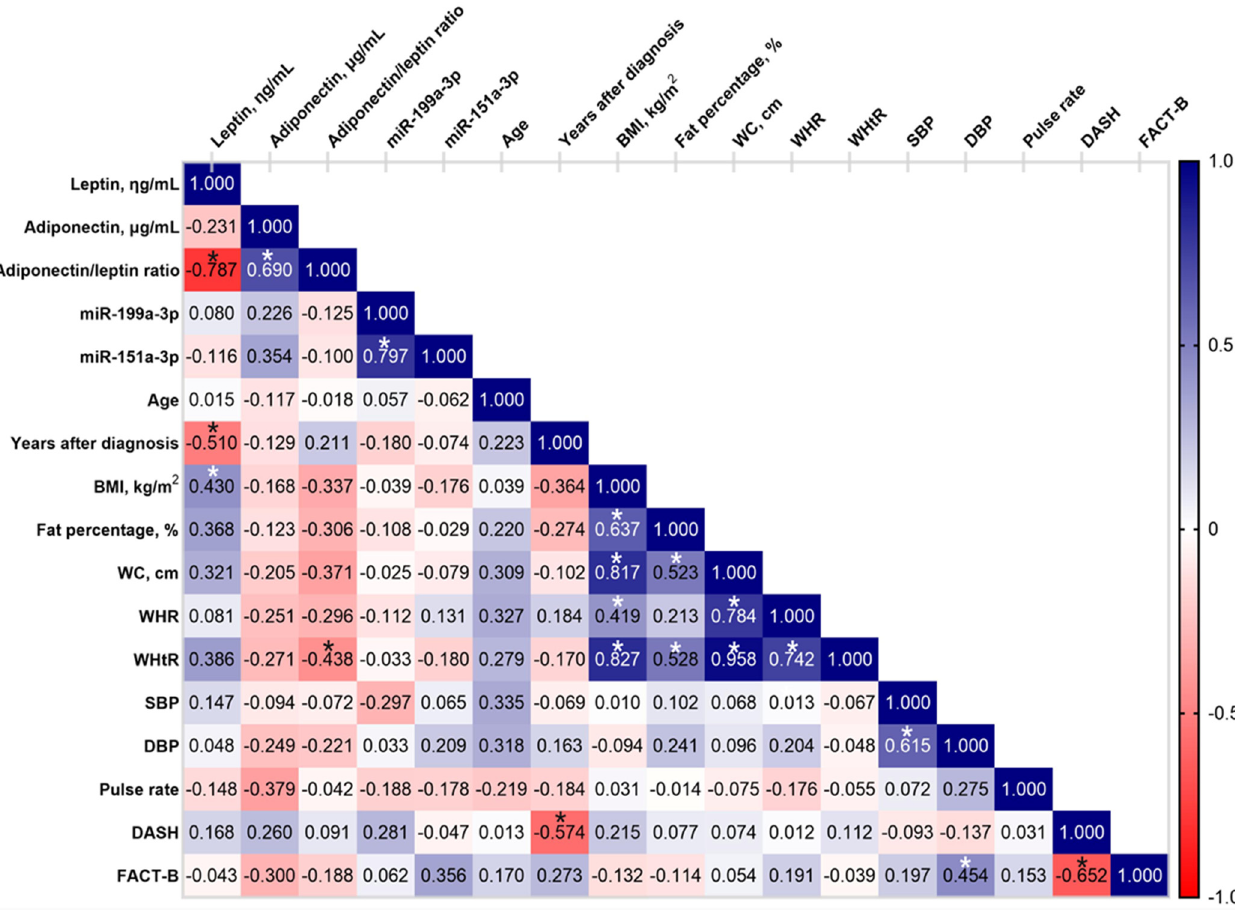
Figure 8. Correlation matrix of leptin, adiponectin level, and adiponectin/leptin ratio with miR-199a-3p, miR-151a-3p, and relevant variables of the study subjects in the BCRL group. As presented by the correlation range (right-hand bar), the darker blue color indicates a stronger positive correlation, the darker red color indicates a stronger negative correlation, and the white color indicates no correlation. The Pearson’s correlation coefficient (r) values for each correlation are shown in the rectangles and the asterisks represent a significant p value, p < 0.05, between the pairwise correlation. BMI body mass index, WC waist circumference; WHR waist-to-hip ratio; WHtR waist-to-height ratio; SBP systolic blood pressure; DBP diastolic blood pressure; DASH Disabilities of Arm, Shoulder, and Hand; FACT-B Functional Assessment of Cancer Therapy–Breast.